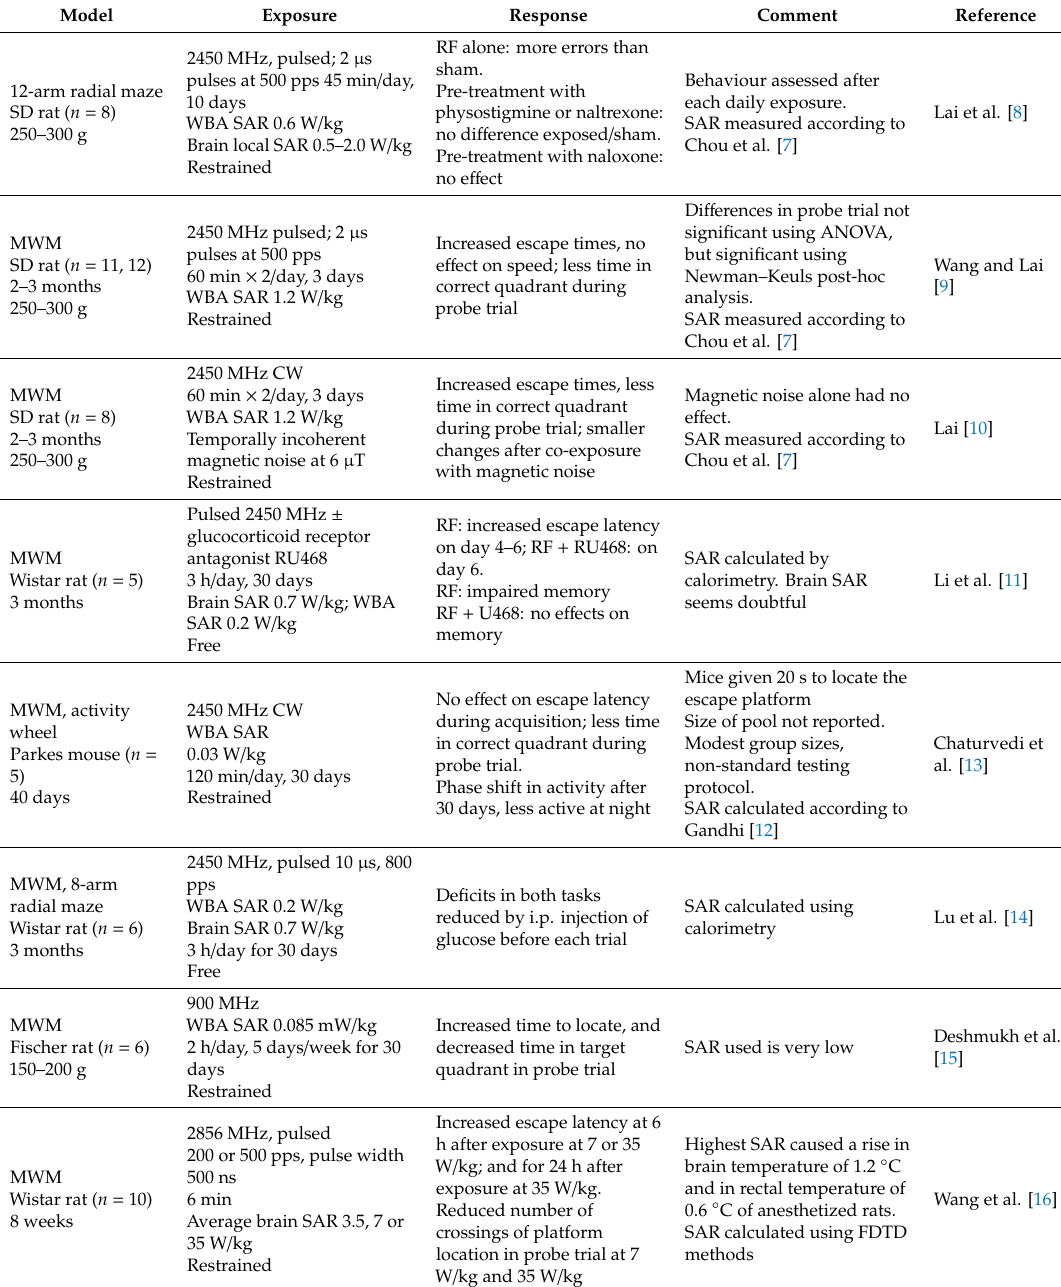
Table 1. Behavioural studies with radiofrequency (RF) fields reporting significant impairments of place learning and spatial